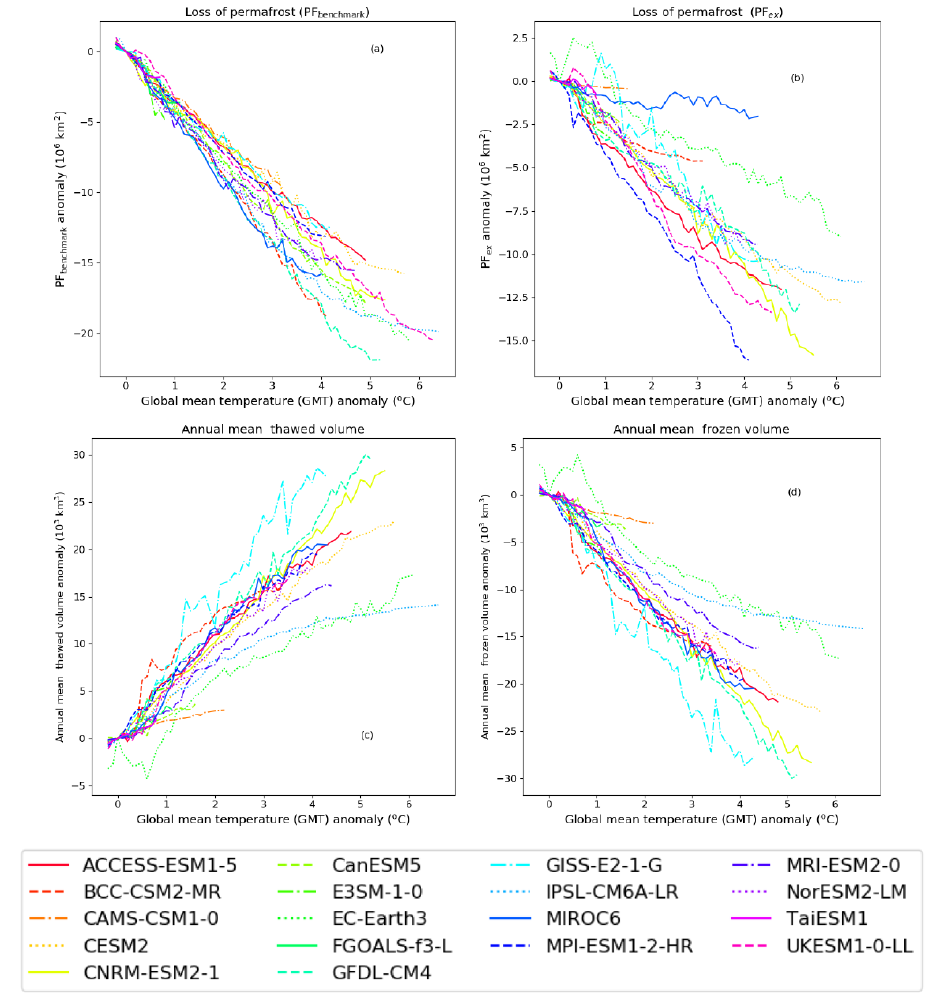
Figure 12. Projections of (a) loss of permafrost extent defined as PF benchmark derived from the MAAT, (b) loss of permafrost extent defined as PF ex derived from the soil temperatures, (c) increase in annual mean thawed volume and (d) loss of annual mean frozen volume as a function of global surface air temperature change for the CMIP6 models. All the available scenarios are superimposed on one figure and the results binned into 0.1 ◦ C global surface air temperature change (GSAT) bins. PF ex is greater than 1 × 10 6 km 2 in all